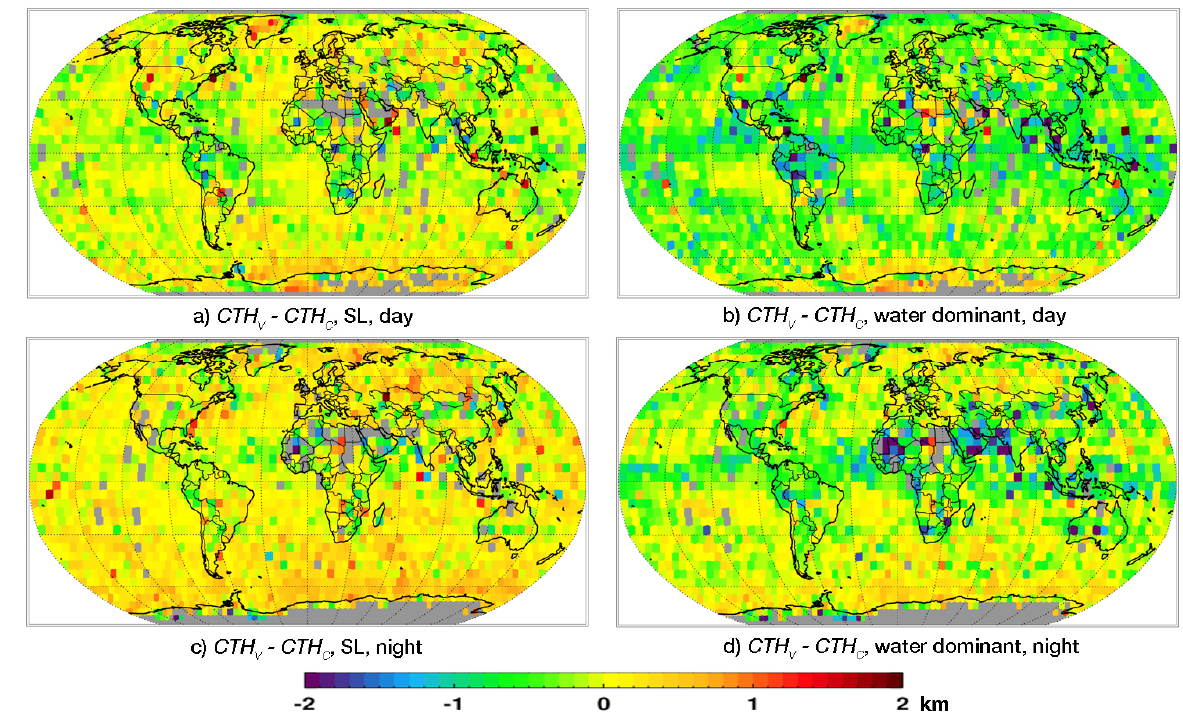
Figure 7. Regional mean cloud-top height differences between CV1S (CTH V ) and CALIOP (CTH C ) for 0/100 liquid water clouds, JAJO 2015–2016. ( a , c ): Single-layer (SL), ( b , d ): all with liquid tops, ( a , b ): day, ( c , d ): night. ( a , b ): day, ( c , d ):